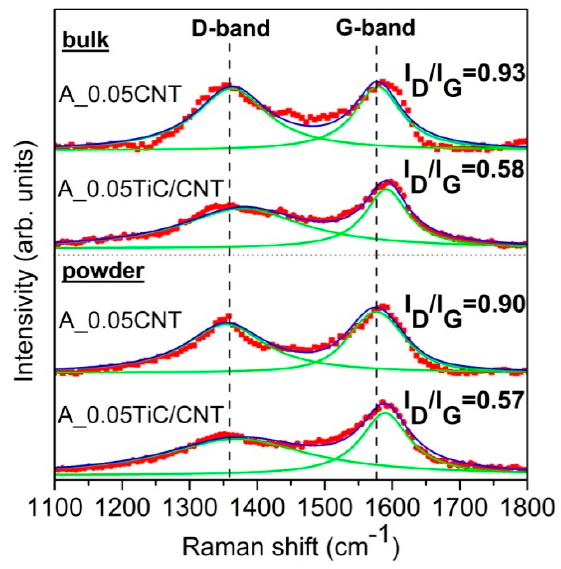
Figure 6. Raman analysis of powders and bulk materials: A_0.05CNT and A_0.05TiC/CNT.